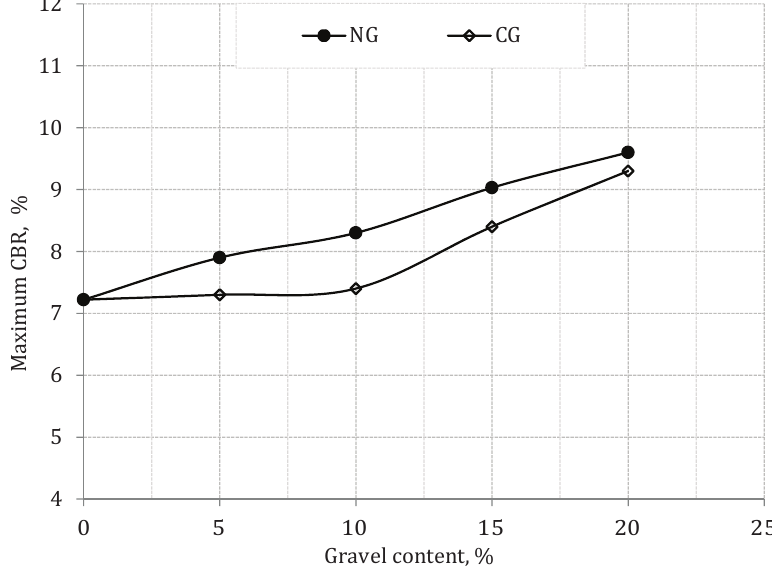
Figure 9. Variation of CBR for the clay with NG and